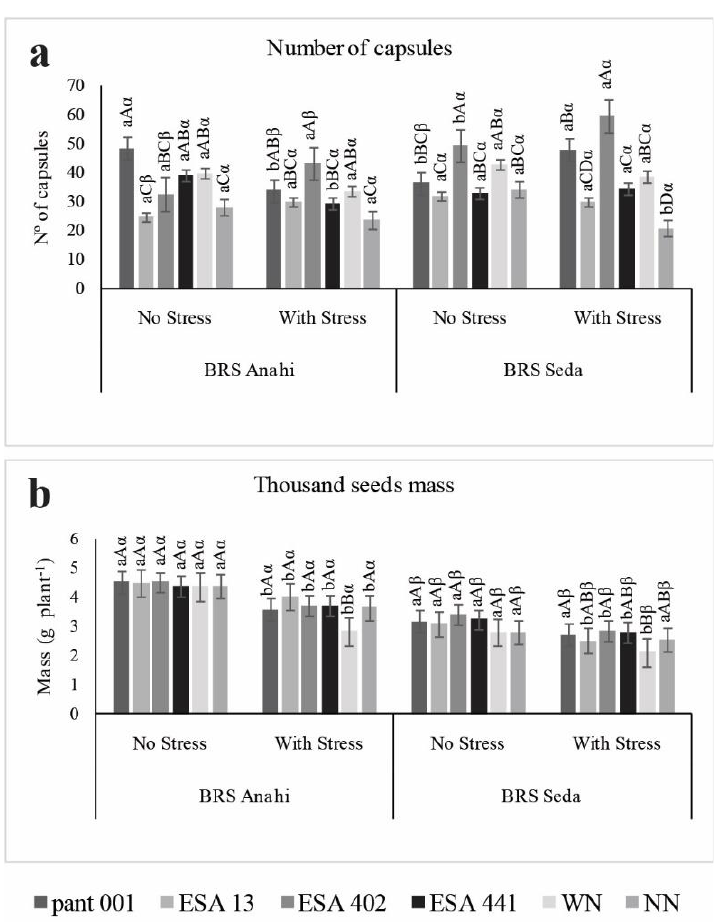
Figure 5. Number of capsules per plant ( a ) and weight of one thousand seeds ( b ) of two sesame cultivars (BRS Seda and BRS Anahí) inoculated with bacilli and under water restriction. WN-with nitrogen and NN-no nitrogen. Lowercase letters compare the water regime within each cultivar; capital letters compare treatments within each cultivar; Greek letters compare cultivars, according to Tukey ’ s test at 5% probability.